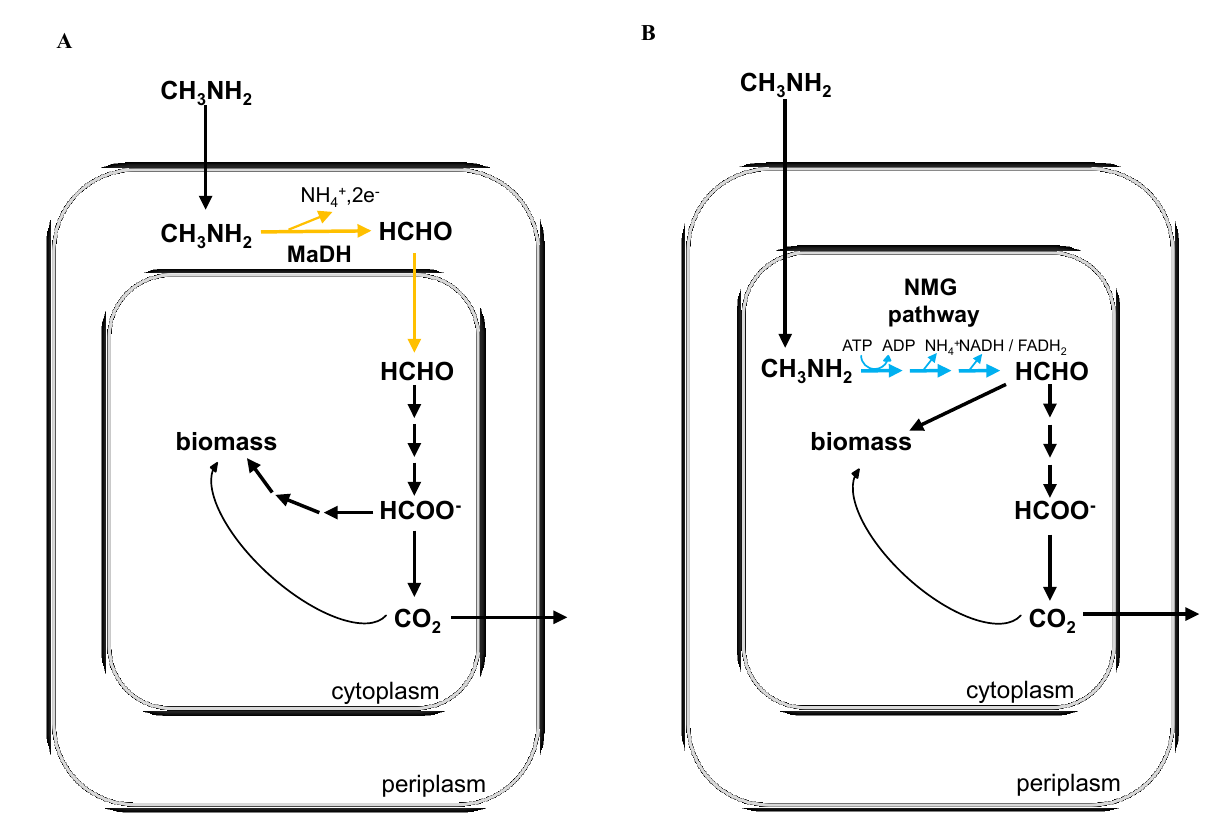
Figure 1. ( A ) A schematic of methylamine metabolism using the methylamine dehydrogenase (encoded by the mau gene cluster) for methylamine oxidation (orange). During methylamine growth mediated by methylamine dehydrogenase, formate is the branch point of C 1 metabolism and the tetrahydrofolate (H 4 F) dependent pathway is essential for C 1 assimilation. ( B ) A schematic of methylamine metabolism using the N -methylglutamate pathway for methylamine oxidation (blue). During methylamine growth mediated by the N -methylglutamate (NMG) pathway, formaldehyde is the branch point of C 1 metabolism and the H 4 F dependent pathway is not used at all for C 1